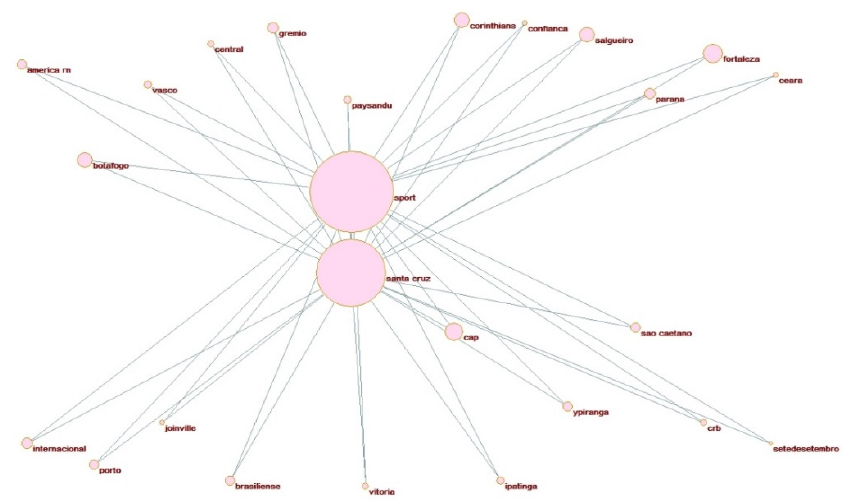
Figure 5. Clash affinity between Sport Recife and Santa Cruz.